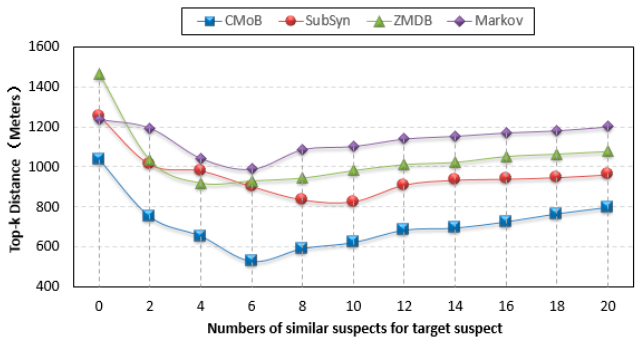
Figure 10. Top- k Errors.